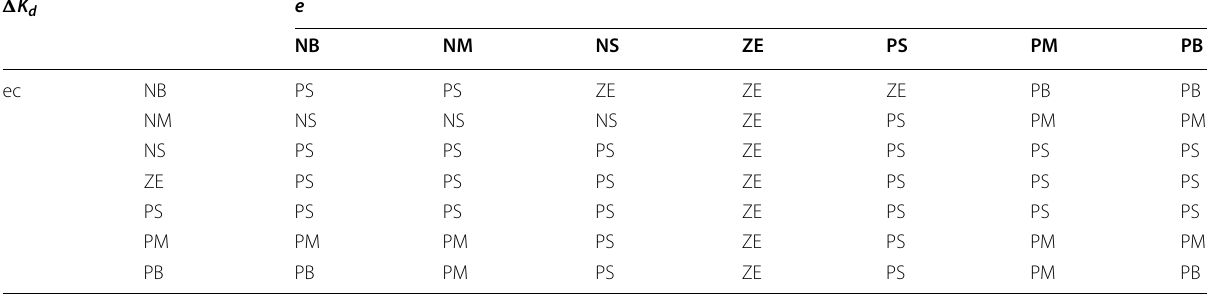
Table 2 Fuzzy control rule table of (cid:31) K d (cid:31) K d